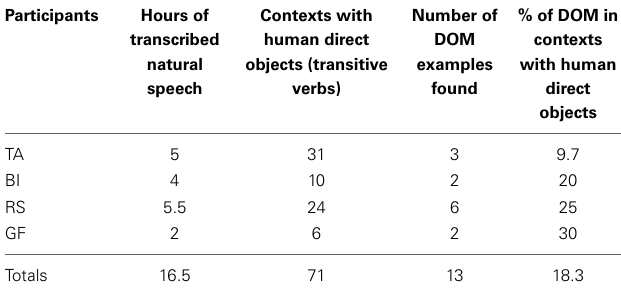
Table 5 | Percentage of adult DOM use in possible contexts (Austin,